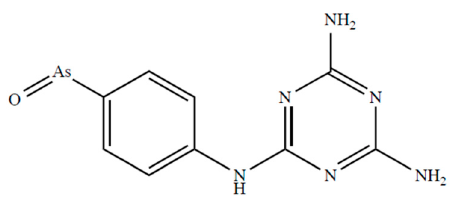
Figure 3. Chemical formulae of melarsen oxide.